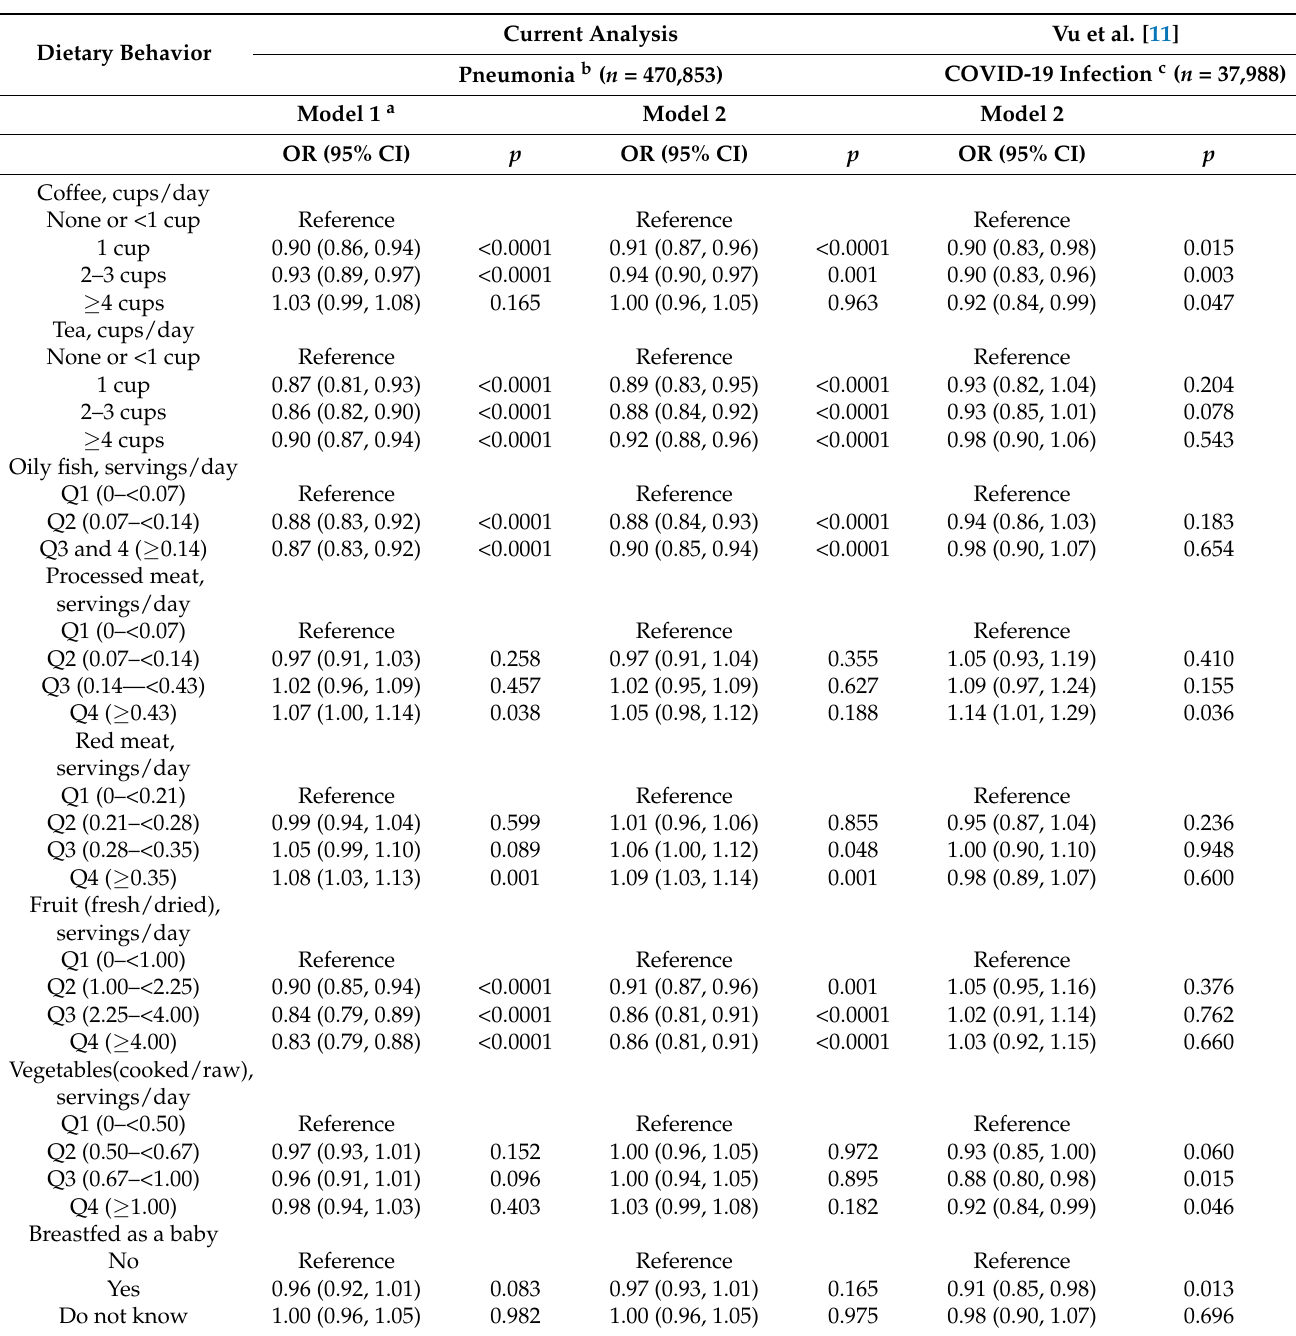
Table 2. Dietary behaviors and risk of pneumonia.